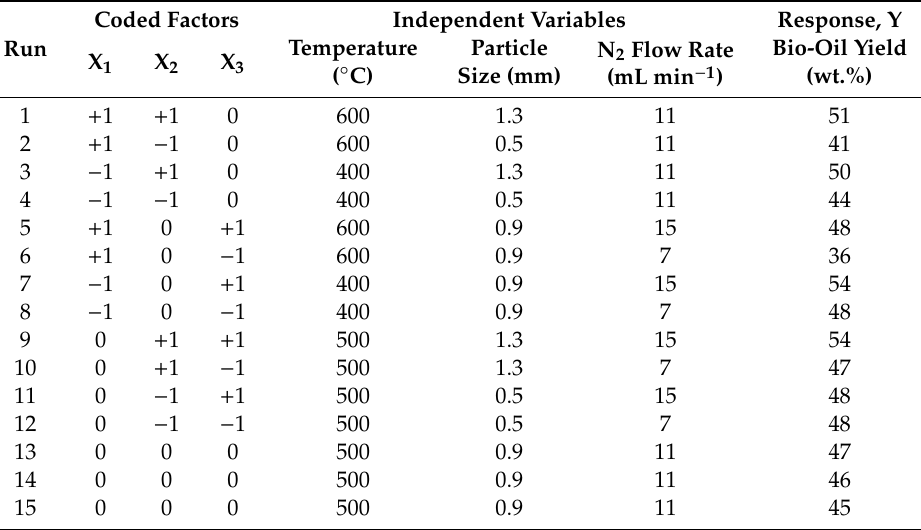
Table 2. Box-Behnken three-level three-factor fractional factorial design